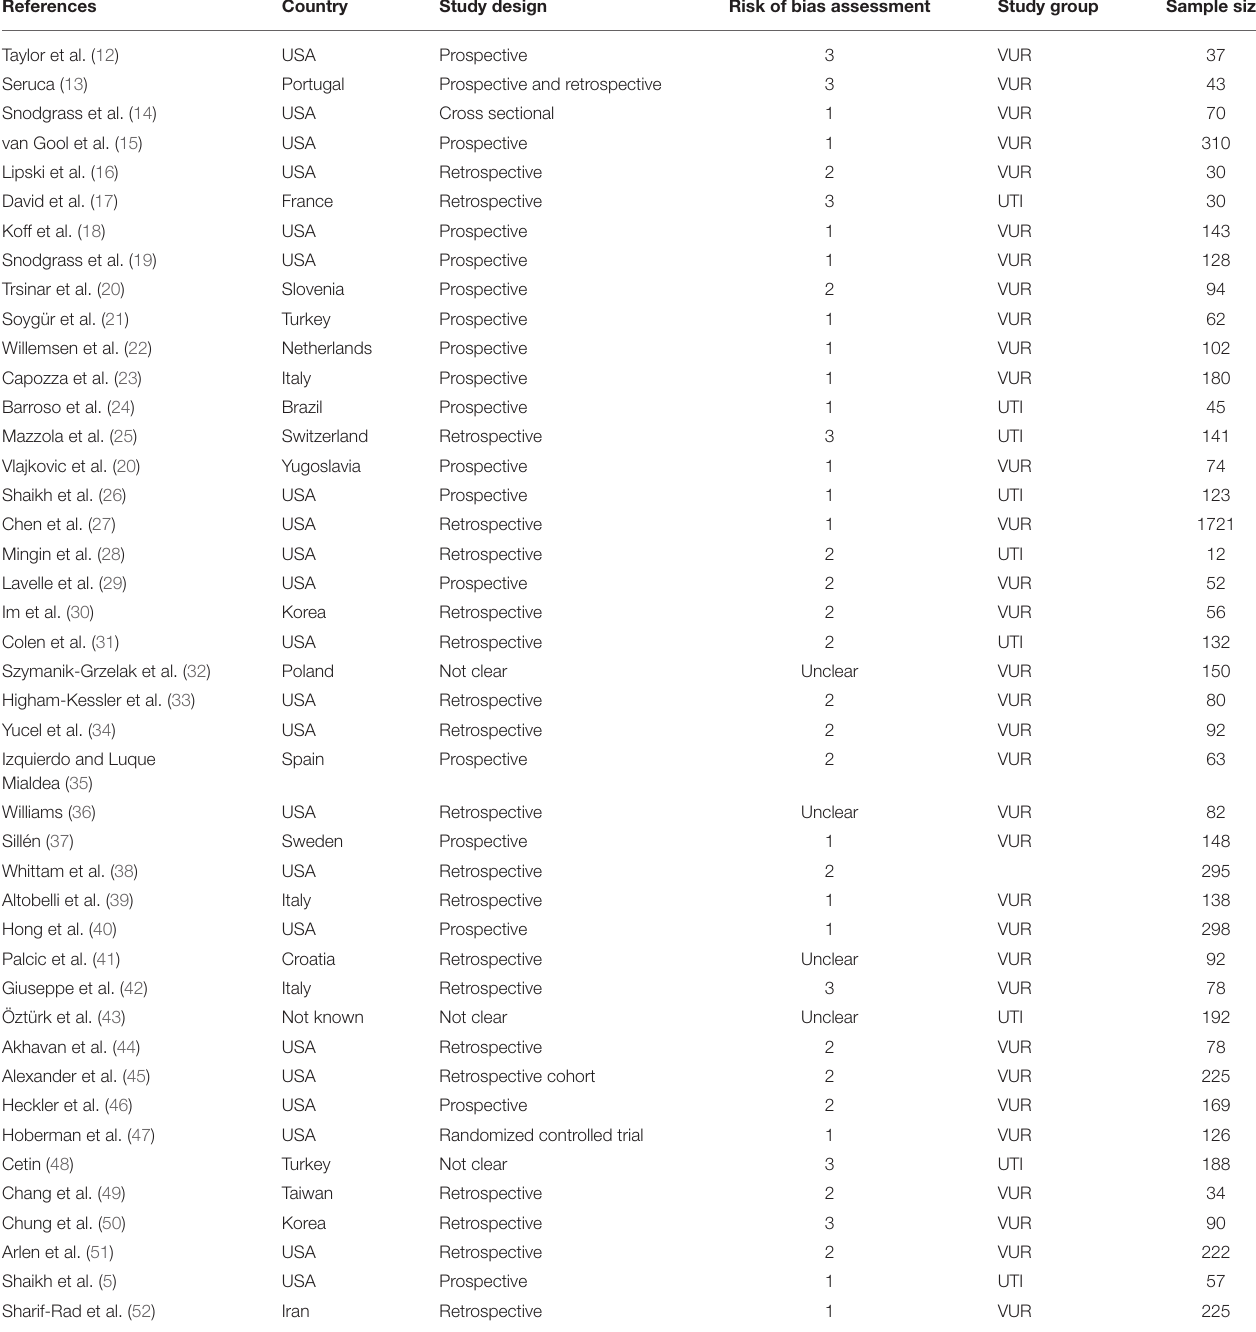
TABLE 1 | Basic characteristics of studies included in the systematic